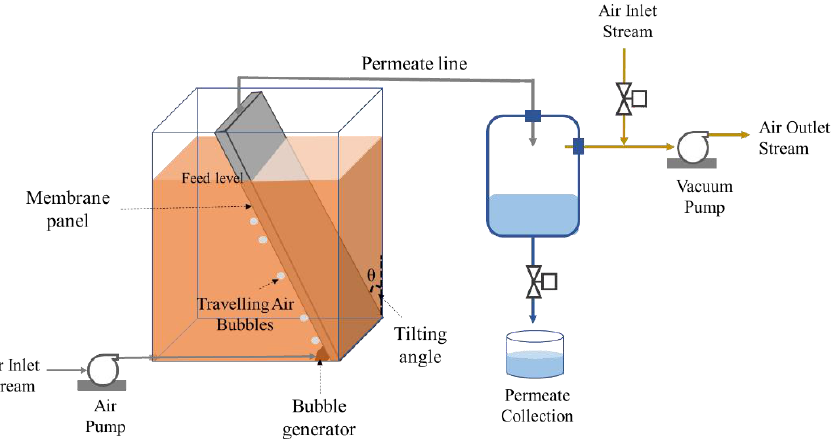
Figure 1. Schematic diagram of the experimental setup of filtration system.